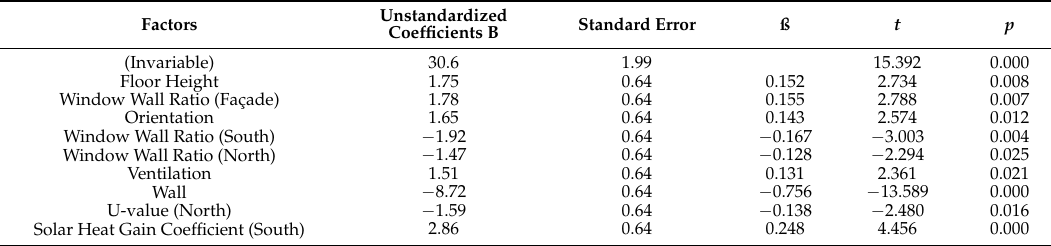
Table 4. Coefficient (a) for Heating Load.